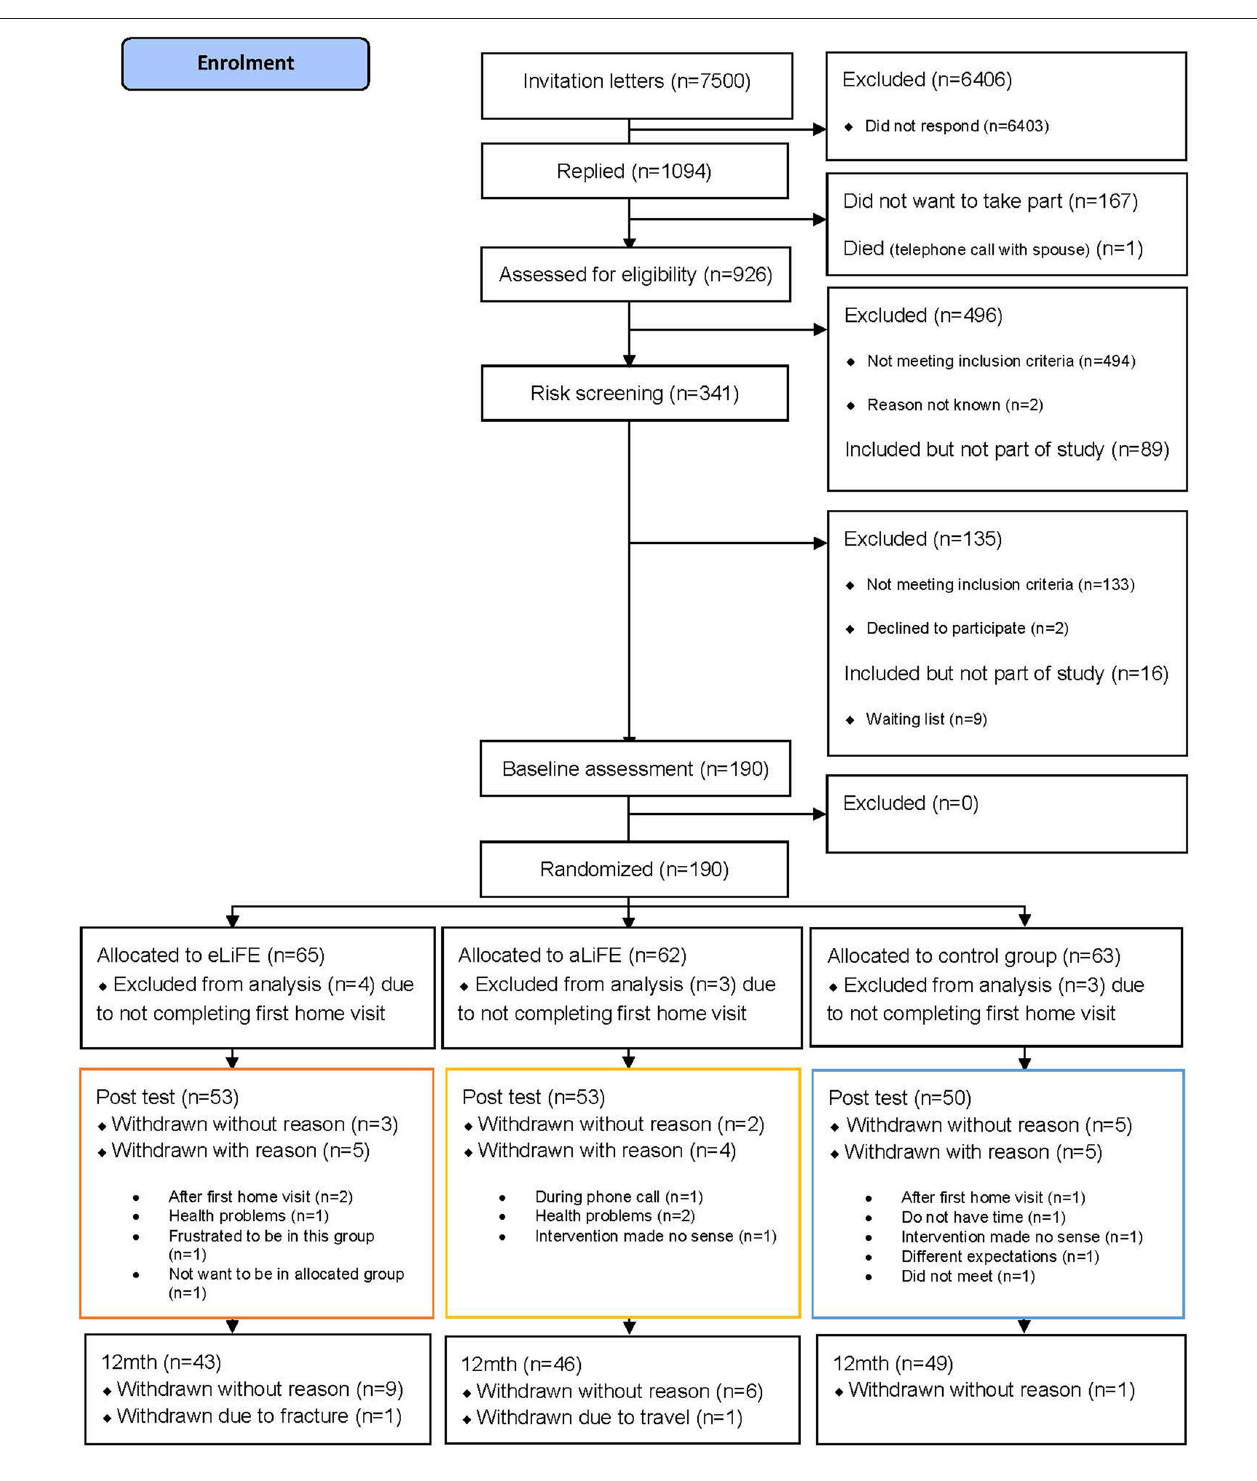
FIGURE 1 | Flow chart.